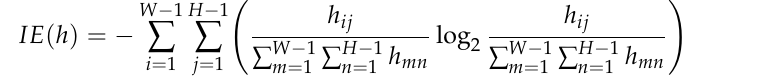
Table 2. Root Mean Square Error ( RMSE ) , Average Deviation ( AD ), Pearson Correlation Coefficient ( PCC ) and and Difference of surface Information Entropy ( DIE ) for separate pairs of echelon − approximations a C , of Figure 3. Taken from [26].